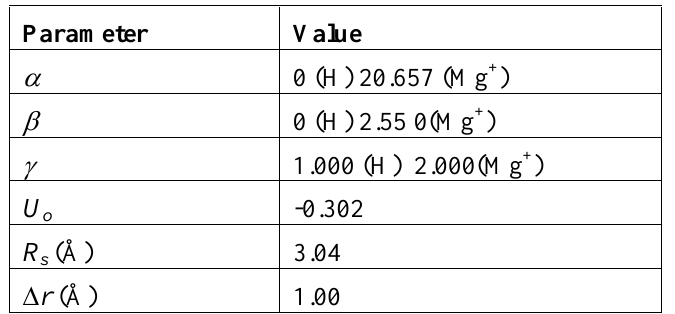
Table I. Parameters for the hydrogen and magnesium valence electron potentials calculated utilizing density functional theory [18] as well as those for the